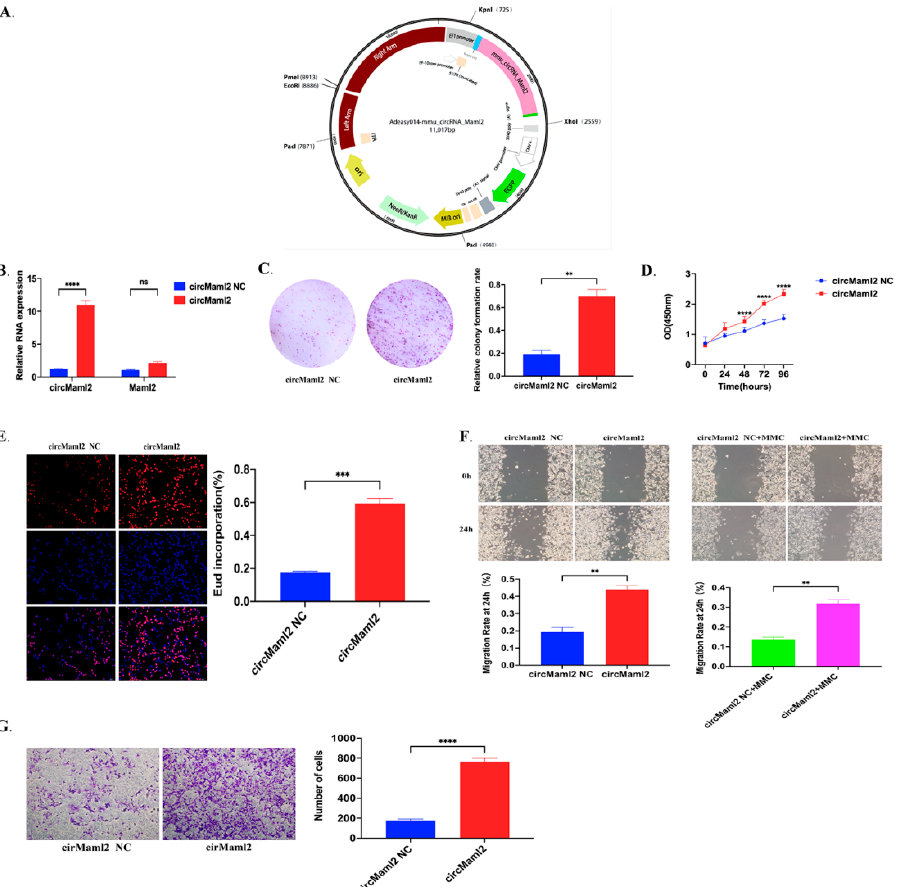
Figure 1. CircMaml2 Upregulation Promotes the Migration and Proliferation of MC38 Cells ( A ) A schematic of the structure and sequence of the adenovirus construct of circMaml2. ( B ) qRT-PCR assays were conducted to confirm increased expression of circMaml2 after transfection with adenovirus targeting circMaml2 (**** p < 0.0001, ns p = 0.0789, two-way ANOVA). ( C ) A colony formation assay was performed to examine the role of CircMaml2 in cell proliferation (** p = 0.0018, t test). ( D ) Growth curves of MC38 cells transfected with Ad-circMaml2 detected by the CCK-8 assay (**** p < 0.0001, two-way ANOVA). ( E ) The number of EdU-positive cells detected by the EdU assay in MC38 cells transfected with Ad-circMaml2 (*** p = 0.0002, t test). ( F , G ) Migration of MC38 cells transfected with Ad-circMaml2 detected by wound healing and transwell experiments using (or not using) the MMC preconditioning (** p = 0.0018, ** p = 0.0016, **** p < 0.0001, t test). All data are presented as mean + SEM. ns, not significant. n = 3.